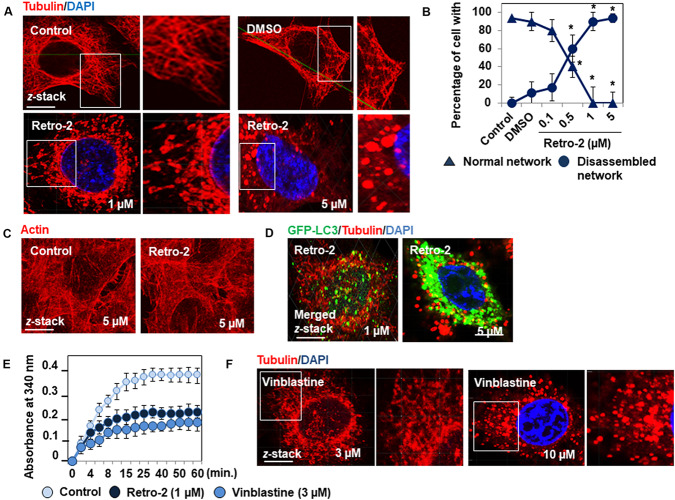
Retro-2 disassembles the MT network of HeLa cells. (A) Representative CLSM micrographs showing the well-organized immunolabeled tubulin network in a control cell and the concentration-dependent disassembly of the tubulin network in cells treated with increasing concentrations of Retro-2. Note the concentration-dependent appearance of fragmented, tubulin-positive bar-like structures and tubulin-positive vesicle-like aggregates. (B) Quantification of cells expressing well-organized or disassembled tubulin-positive fibers in untreated cells and cells treated with DMSO or increasing concentrations of Retro-2. (C) Representative CLSM micrographs showing the actin cytoskeleton in a control cell and in a cell treated with Retro-2 (1 μM). (D) Representative CLSM micrographs showing simultaneously tubulin-positive bar-like structures and small GFP-LC3-positive vesicles (1 μM), and very large GFP-LC3-positive vesicles and tubulin-positive vesicle-like aggregates (5 μM) in GFP-LC3-expressing Retro-2-treated HeLa cells. (E) Graph showing the Retro-2- and vinblastine-induced inhibition of time-dependent tubulin polymerization in vitro. (F) Representative CLSM micrographs showing the concentration-dependent disassembly of the tubulin network in cells treated with increasing concentrations of vinblastin. Note the concentration-dependent appearance of fragmented, tubulin-positive bar-like structures and tubulin-positive vesicle-like aggregates. CLSM micrographs are representative of two separate experiments in duplicate. Scale bar, 10 μm. White boxed regions delineate the areas shown in the adjacent high-magnification images. Confocal quantification was conducted by examining at least 30 cells for each condition ImageJ software. In vitro tubulin polymerization was measured by spectrophotometry at 340 nm and the data recorded at 30-s intervals for 60 min at 37°C. Values represent the average of two separate experiments in duplicate (±SEM). Data were analyzed using the unpaired Student t-test. *P < 0.01 compared to Control (B).